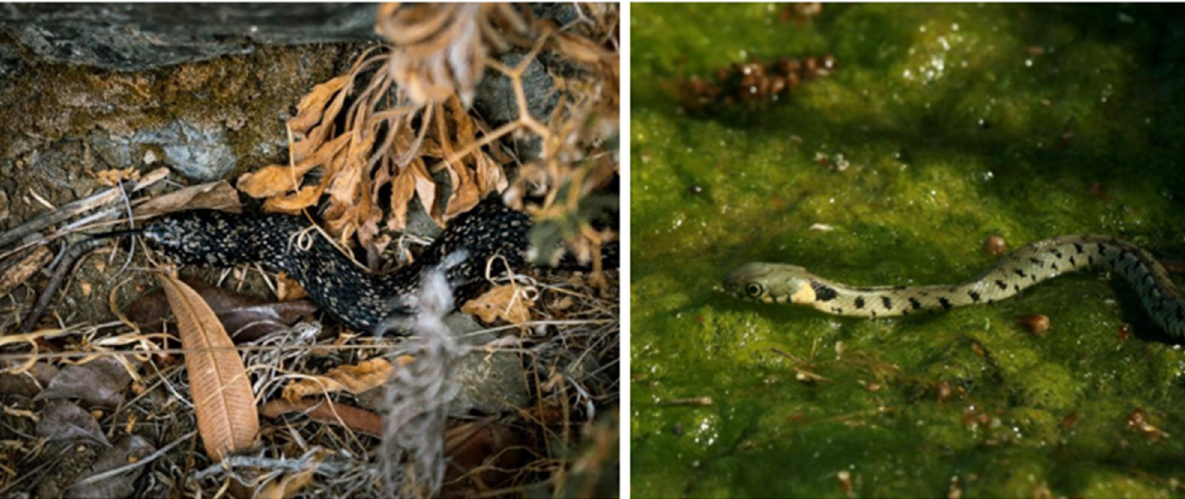
Figure 1. Left: An adult individual of the species N.n.cypriaca of the picturata morph trying to hide below shrubs on the side of the riverbed. Right: A young individual of the normal morph basking on top of algal mat, a very common basking strategy both in lowland and mountainous populations.